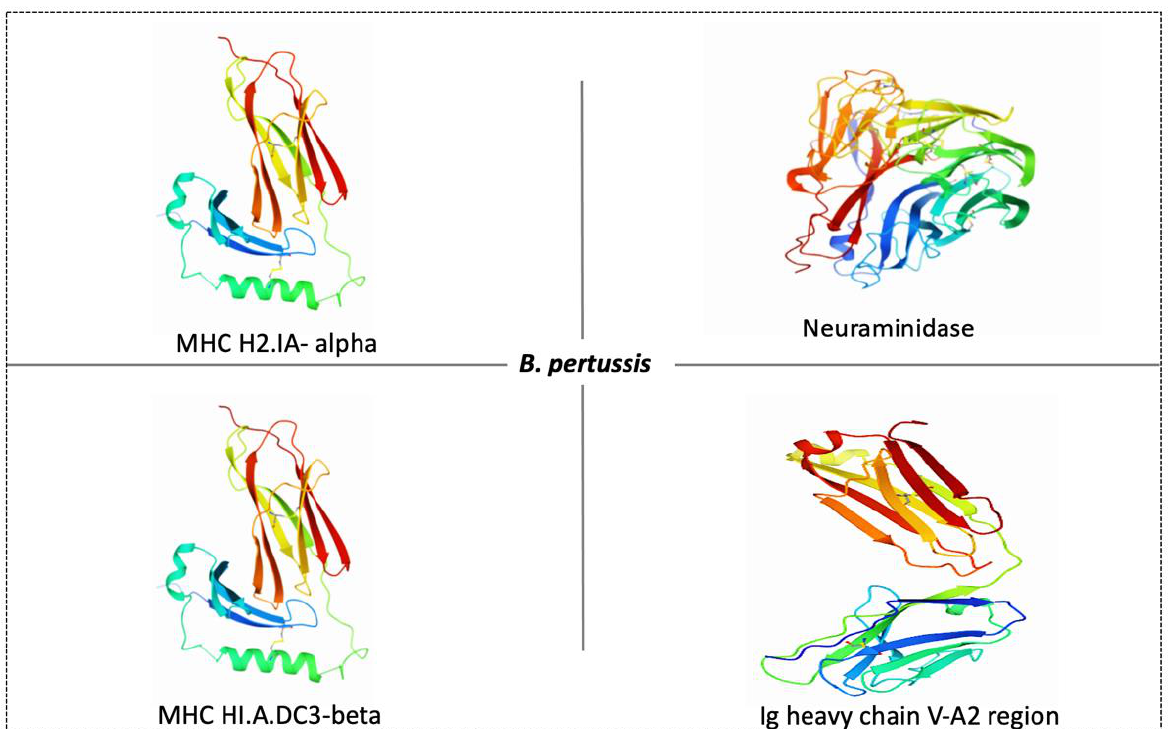
Figure 4. Possible protein targets and their structures for vaccine development against B. pertussis. PDB ID of MHC H2-IA-alpha is 1MHC , neuraminidase is 5TSP, MHC HLA-DC3-beta is 3HPJ and Ig heavy chain V-A2 region is 1IGM.